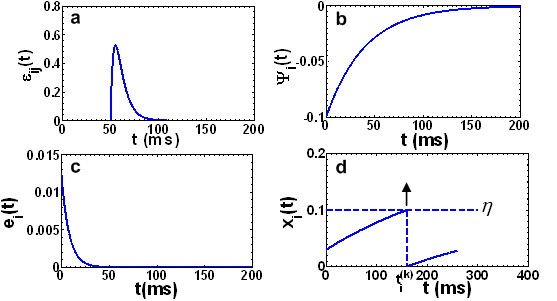
The functions describing the dynamics of a spike neuron. (a) The kernel εij(t) describing the response of xi(t) caused by a pre-synaptic spike at t = 0, with Δax = 50 ms, τs = 3.5 ms, and τm = 8 ms. (b) The function ψi (t) reflecting refractoriness after a spike emitted at t = 0, with δ = 0.1 and τ = 40 ms. (c) The kernel ei(t) representing the dynamics from local current stimulation to the membrane voltage of a neuron. The time constant is identical to τm in (a). (d) The membrane voltage xi (t) firing at time tik when it reaches a threshold voltage δ = 0.1. After firing, it is reset by the function ψi(t) and then re-accumulates via the pre-synaptic spike inputs wijεij(t-tjk)..